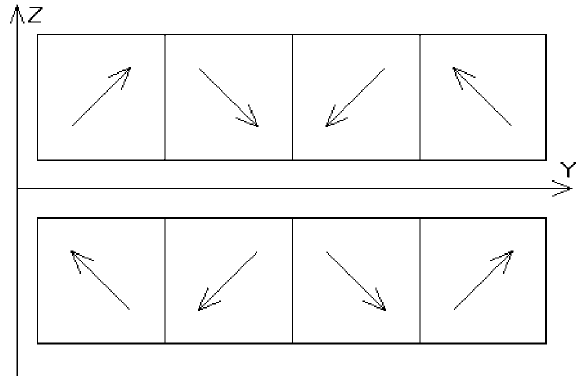
FIG. 3. Rotated wiggler configuration.